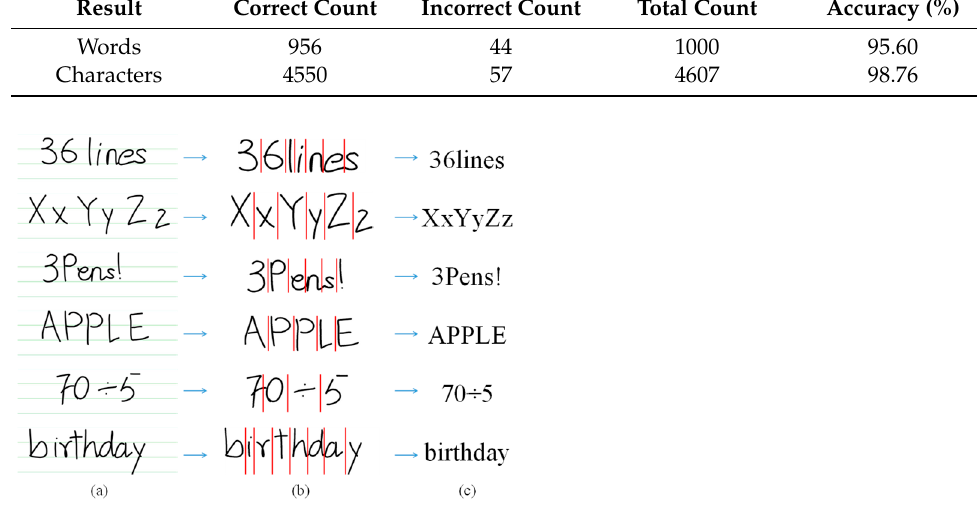
Table 7. Recognition results. Table 6. Segmentation results.